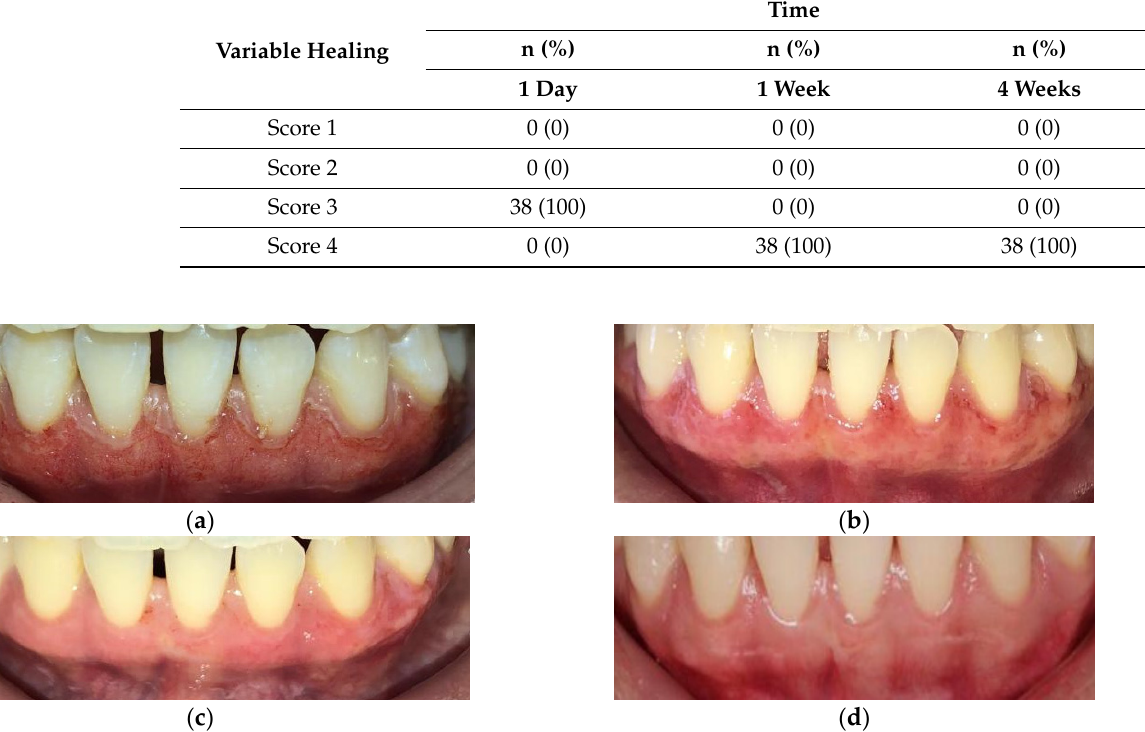
Figure 1. The wound healing process in the anterior mandibular gingiva after the depigmentation treatment. ( a ) Immediately after lasing; ( b ) after 1 day—score 2; ( c ) after 4 days—score 2; ( d ) after 7 days—score 3.